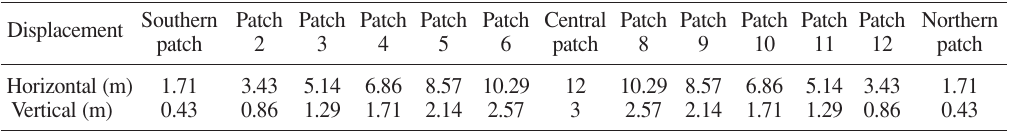
Table II. Horizontal and vertical displacements on the 13 patches along the strike direction in the tapered- displacement Wairarapa Fault Model. Southern Patch Patch Patch Patch Patch Central Patch Patch Patch Patch Patch Northern Displacement patch 2